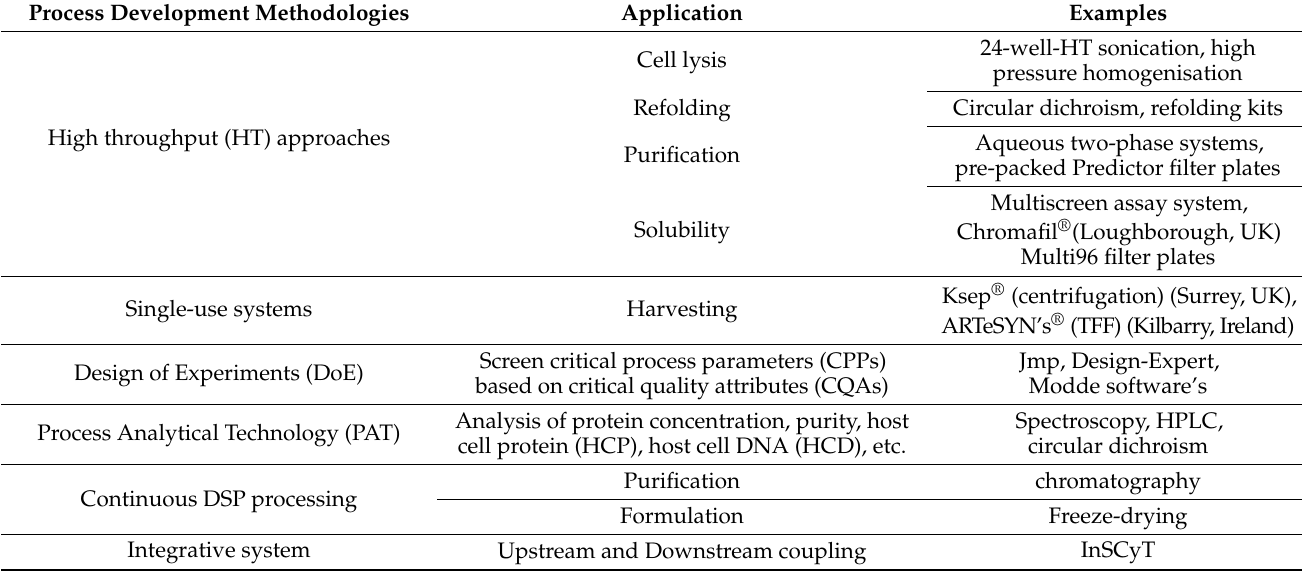
Table 6. Methodologies to enhance downstream processing